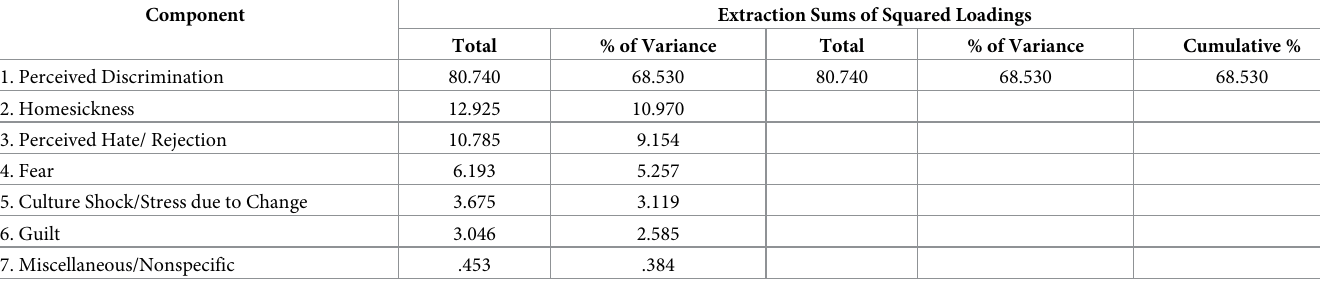
Table 5. Summary of extracted factors of acculturative stress scale for Pakistani students.